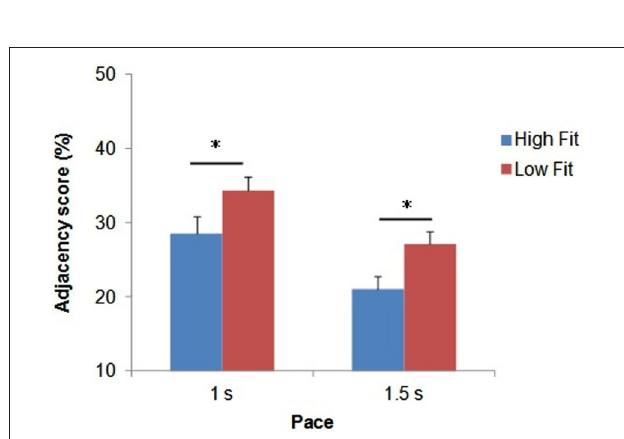
FIGURE 1 | Experimental protocol . Upper: schema of the entire session. After the familiarization period, the participants alternated blocks of RNG tasks and count (CNT) tasks at the slow or fast pace in a counterbalanced order. [HbO 2 ] and [HHb] concentrations were continuously monitored during